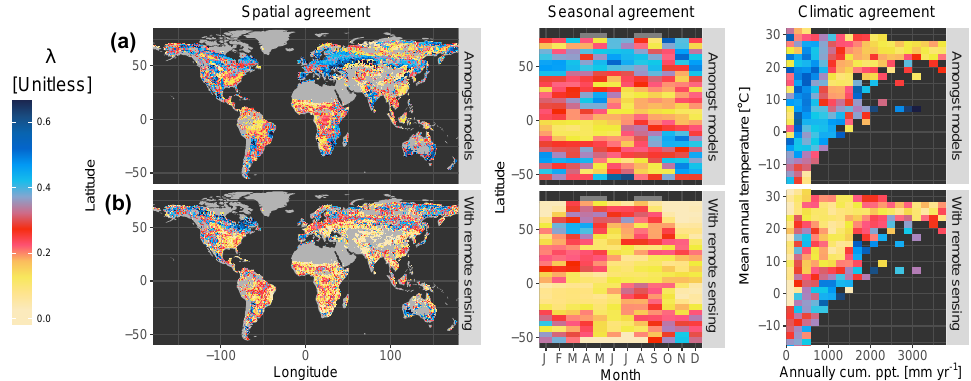
Figure 7. Agreement amongst models and between models and remote sensing for all transitions and all fluxes together. The agreement amongst models (a) is calculated as the mean of all λ values calculated for each model pairs, while the agreement with remote sensing (b) is the mean values of λ for each model with respect to the remote sensing